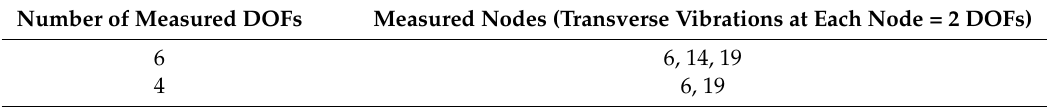
Table 5. Selection of nodes for corresponding numbers of measured coordinates in the tube roll. Number of Measured DOFs Measured Nodes (Transverse Vibrations at Each Node = 2 DOFs) 6 6, 14, 19 4 6, 19